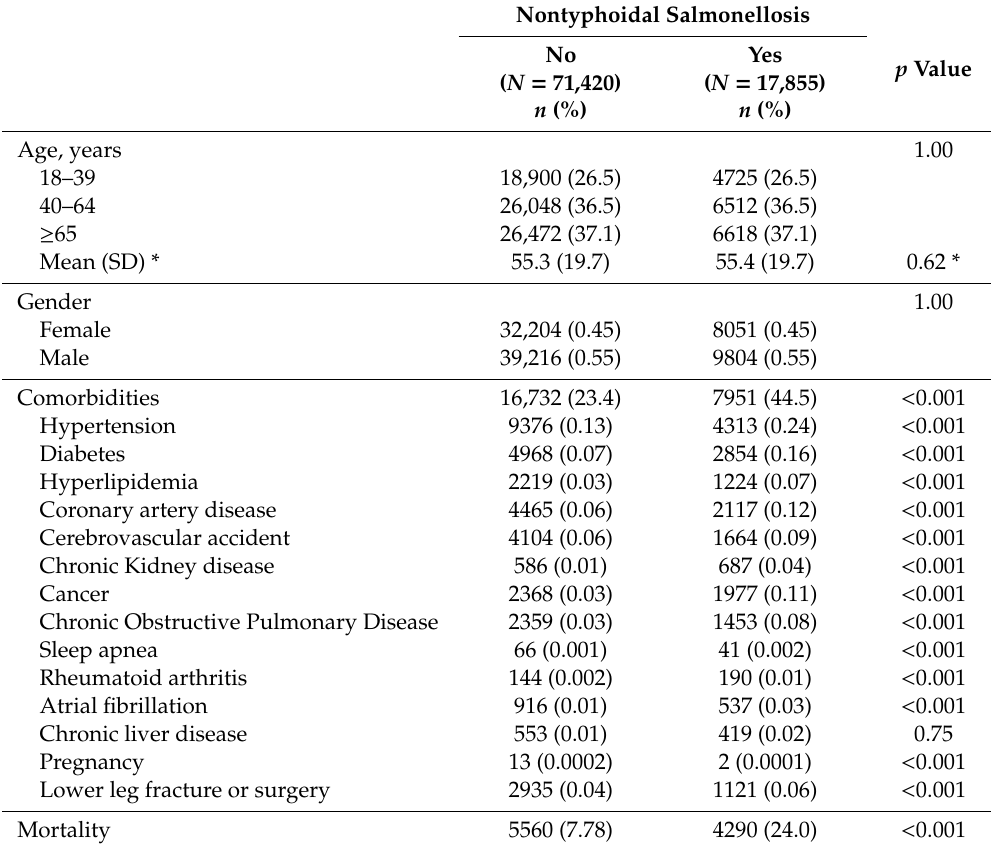
Table 1. Baseline characteristics of the nontyphoidal salmonellosis (NTS) and non-NTS